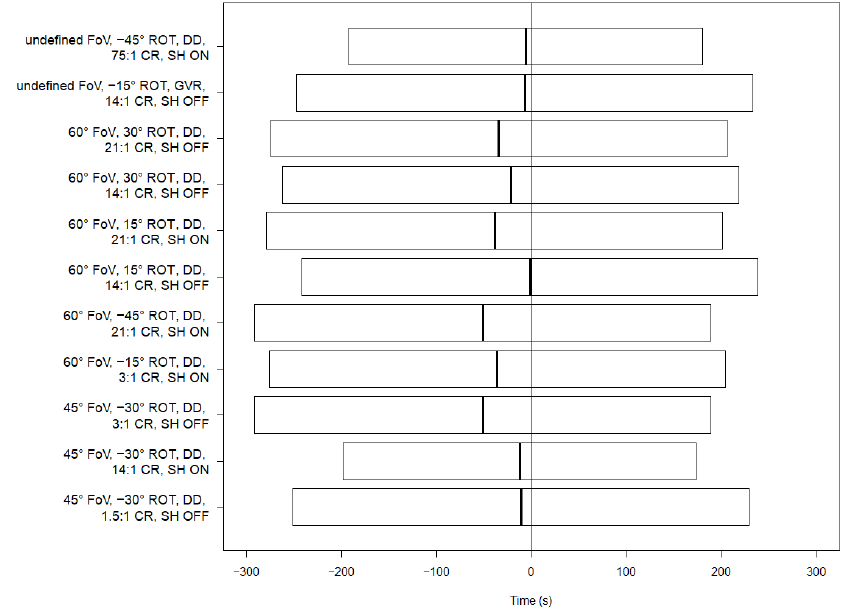
Figure 5. 95% CIs of each factor quintet that can decrease completion